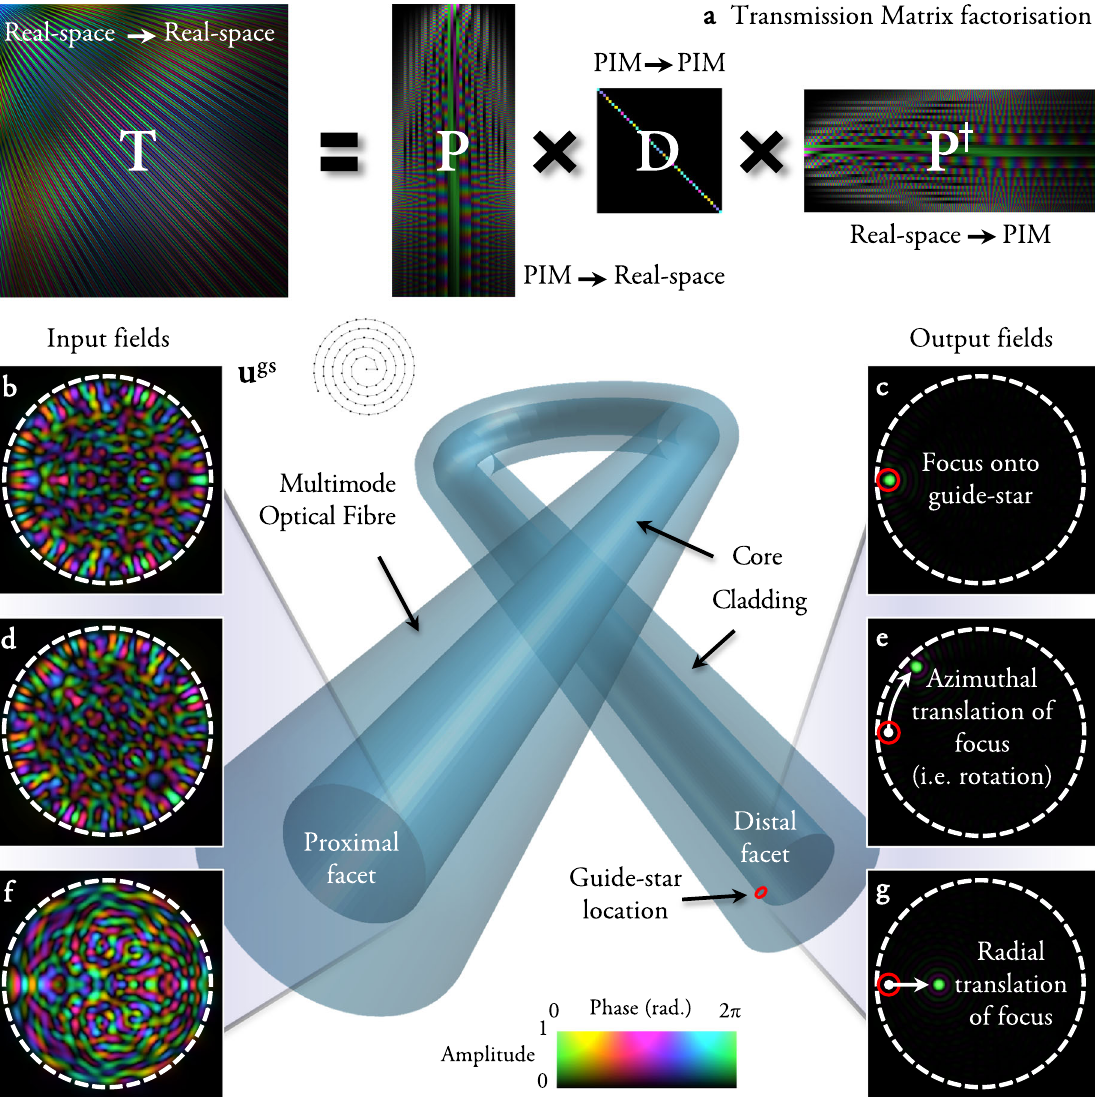
Fig. 1 Field transformations through multimode fi bres. a The TM of an ideal MMF may be factorised into the product of three matrices. Shown is a low- dimensional example of these matrices for an MMF that supports 42 modes per polarisation at a wavelength of 633 nm. The scale-bar (shown at the bottom of the fi gure) indicates the amplitude (encoded in the brightness) and phase (encoded in the colour) of each complex matrix element. When real- space pixels are ordered outwards along an Archimedes spiral (example shown inset), translational correlations in the real-space TM are highlighted, i.e., a single row is similar to a spatially shifted copy of adjacent rows. b An example of a proximal fi eld u gs required to form a focus (shown in green in ( c )) onto a guide-star at the edge of the distal facet of an ideal fi bre (position of guide-star indicated by a red circle). The scale-bar representing the complex value of the electric fi eld at the proximal and distal facets is the same as described in ( a ). Due to the rotational memory effect, by rotating the input fi eld around the fi bre axis ( d ) the output fi eld is rotated by the same angle, moving the focus azimuthally ( e ). Using knowledge of u gs and P enables estimation of the TM of the system, and prediction of the proximal fi eld ( f ) required to radially translate the focus ( g ). These simulations model an ideal fi bre supporting 754 modes per polarisation at a wavelength of 633 nm — this mode capacity is used for all simulations throughout the rest of the